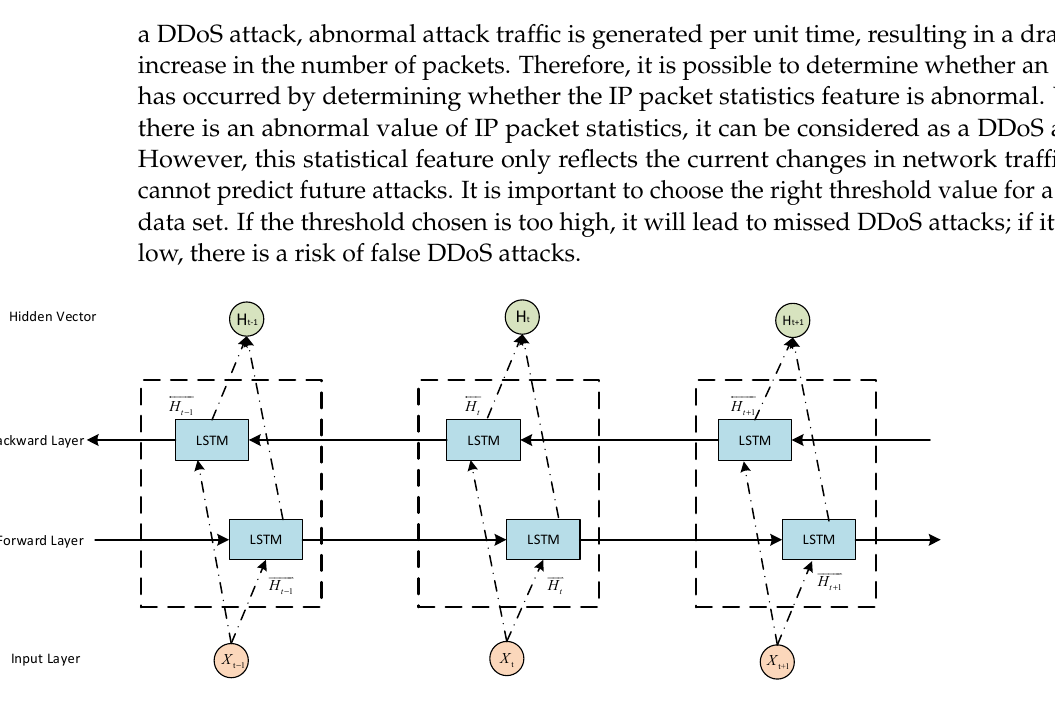
Figure 6. Temporal feature extraction model.